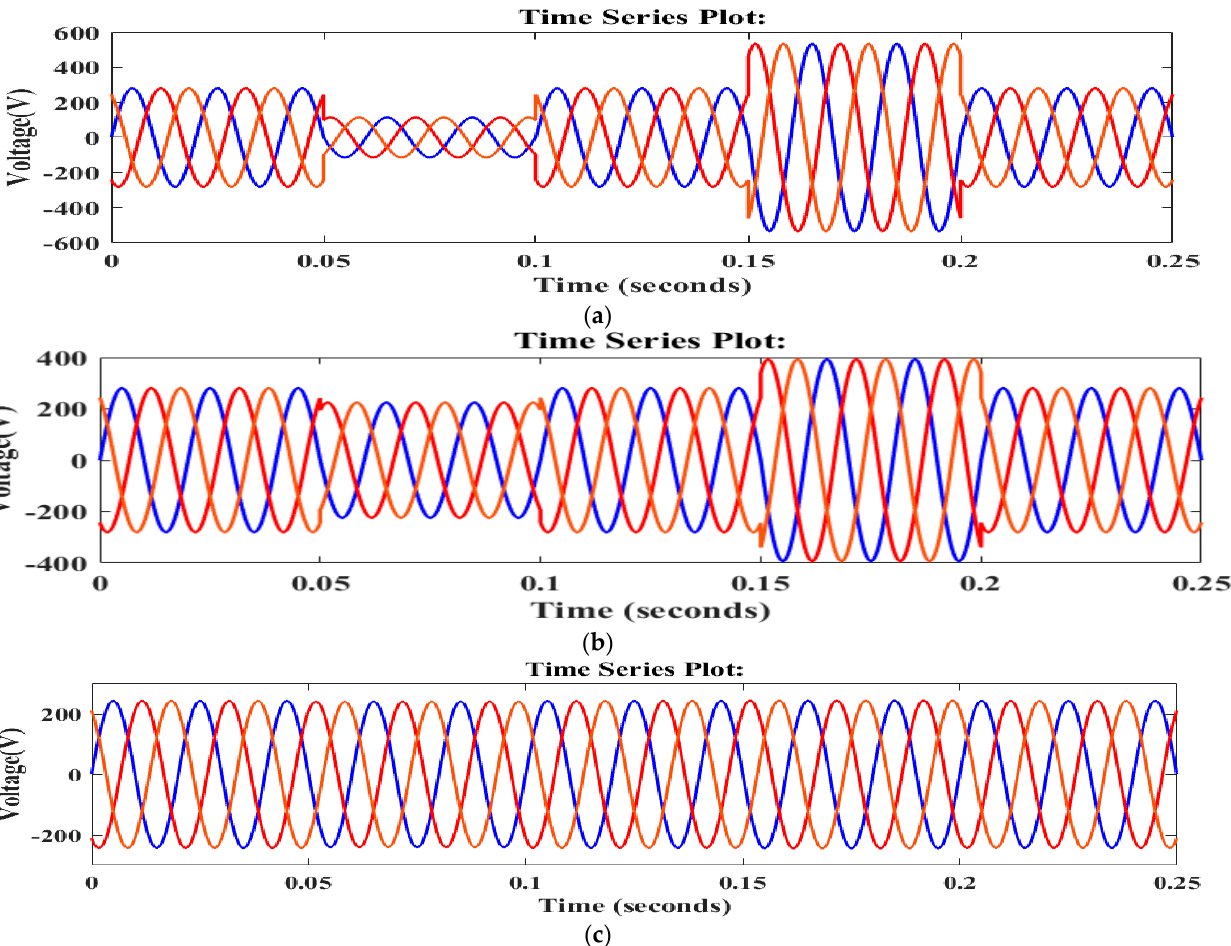
Figure 13. ( a ) MG operation through voltage-sag and voltage-swell: ( a ) PID-controller. ( b ) MG operation through voltage-sag and voltage-swell: fuzzy-PID controller. ( c ) MG operation through voltage-sag and voltage-swell: proposed controller